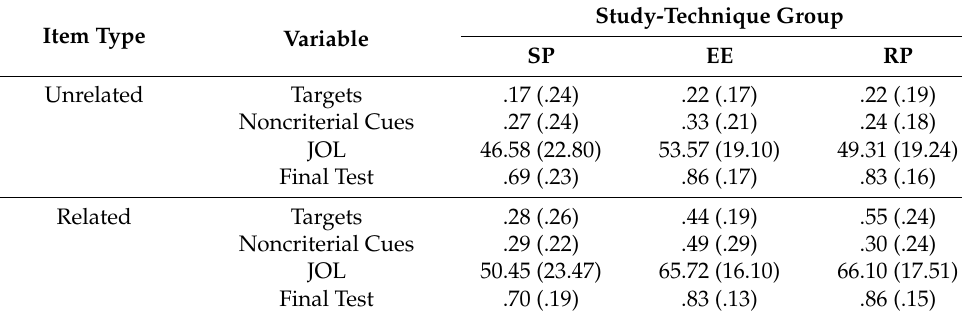
Table 2. Mean cue accessibility, JOL, and final-test